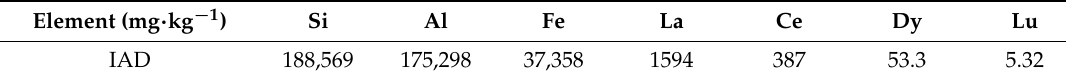
Table 2. Composition of IAD determined in mg · kg − 1